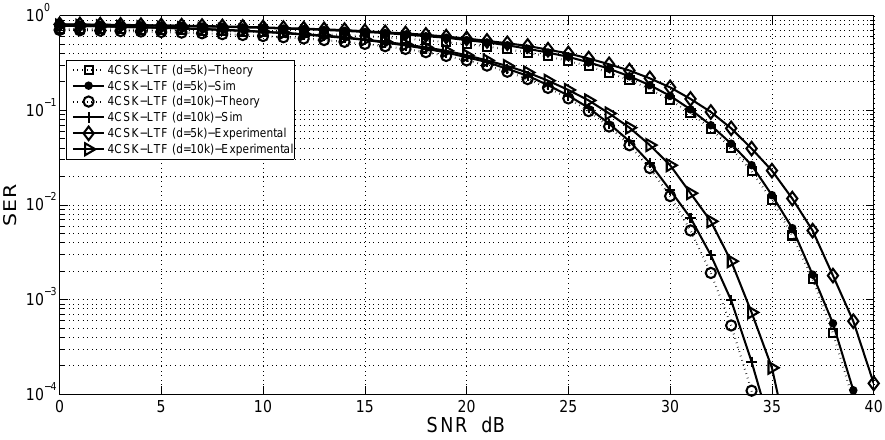
Figure 11. Probability of symbol error for constellation 4-CSK-LTF.